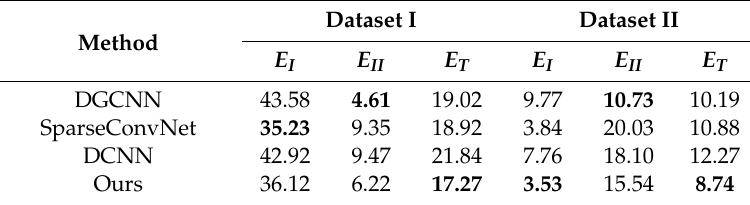
Table 4. Comparison of DGCNN, SparseConvNet, DCNN, and the proposed network on dataset I and II.